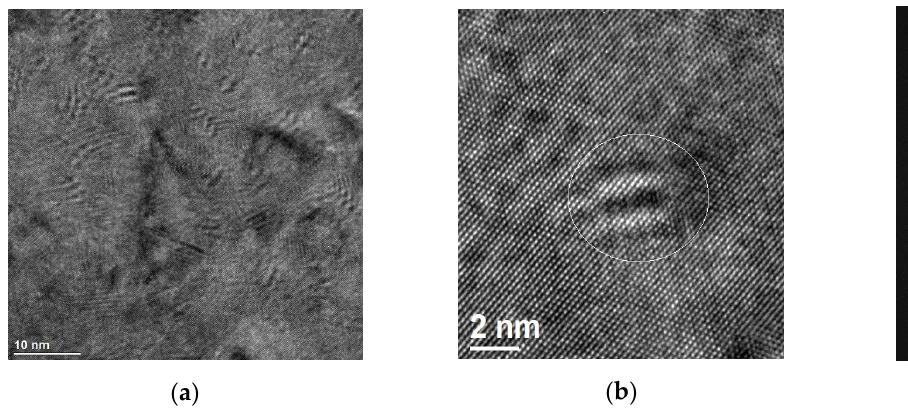
Figure 14. HR TEM image of Cr50WC50 obtained from the [011] fcc Cu zone axis ( a ), a magnified part from the previous image ( b ) and corresponding Fast Fourier Transform calculated form HRTEM ( c ).